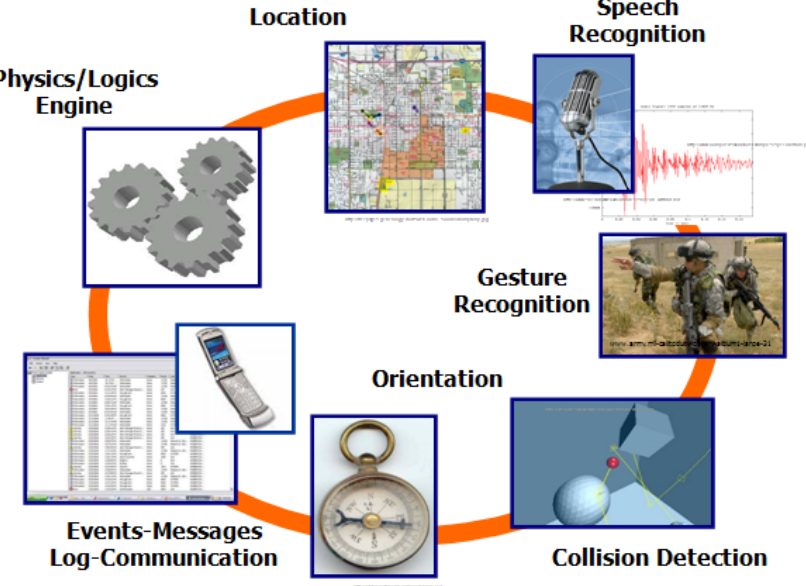
Figure 3. Schematic description of components for the natural an intuitive interface-technological components of the